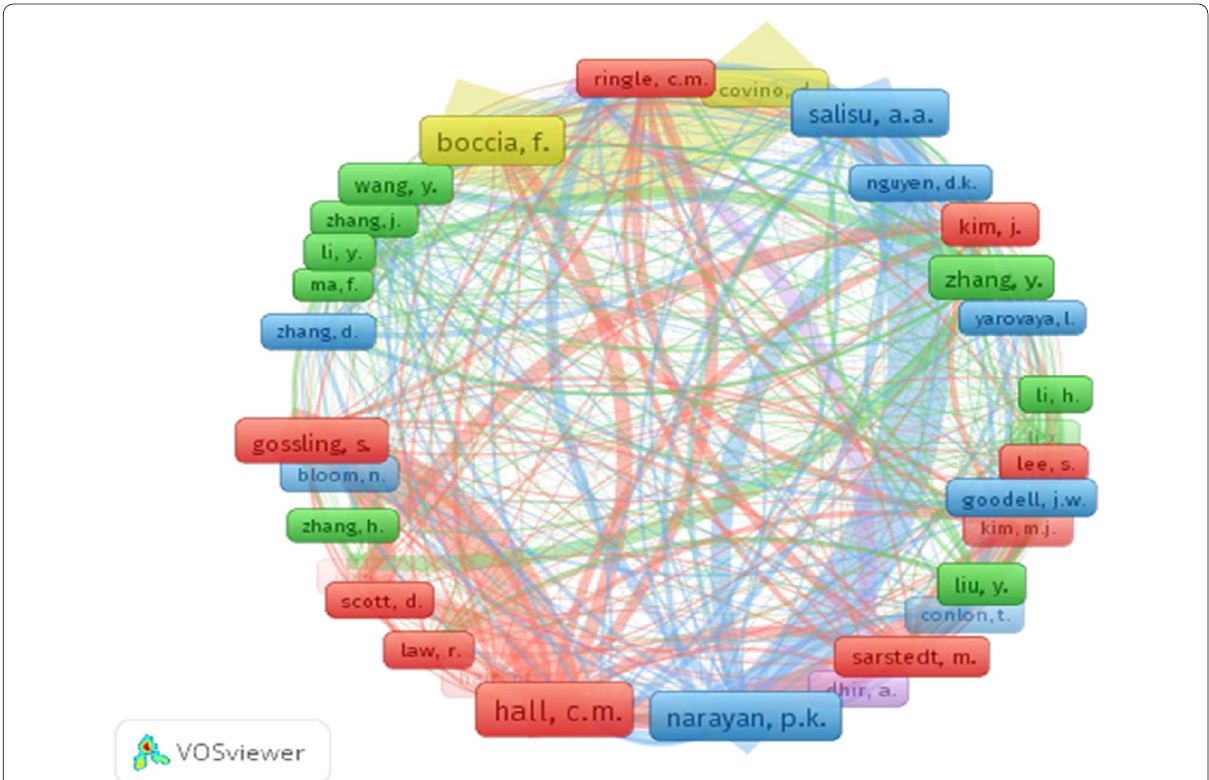
Fig. 5 Network visualization of the largest connected sets of cited sources by authors